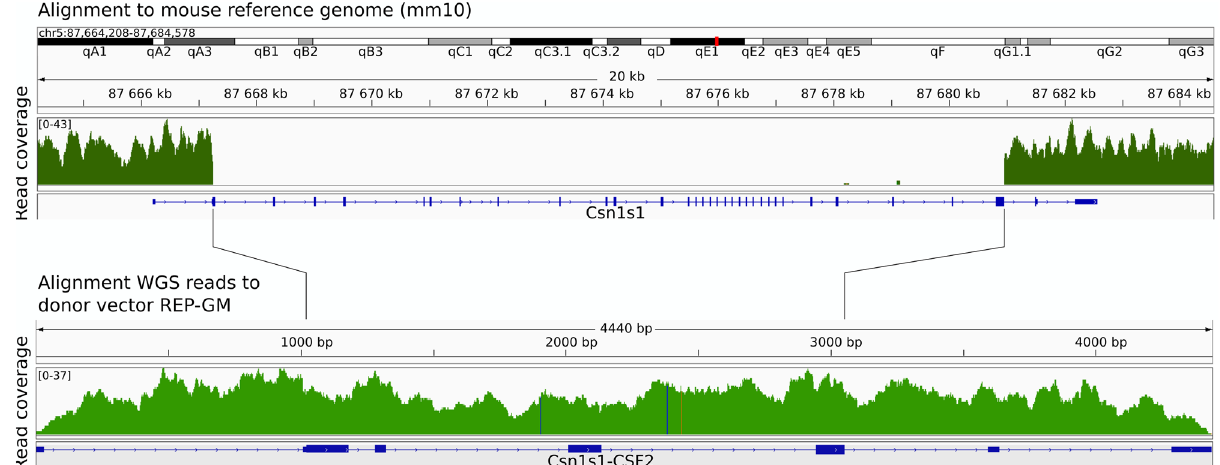
Figure 2. Whole-genome sequencing of the REP-GM homozygous line. Mouse Csn1s1 locus lost 13.7 Kb of the coding sequence and the hGMCSF transgene was inserted instead. Three SNP located at the hGMCSF introns were present in the original vector.